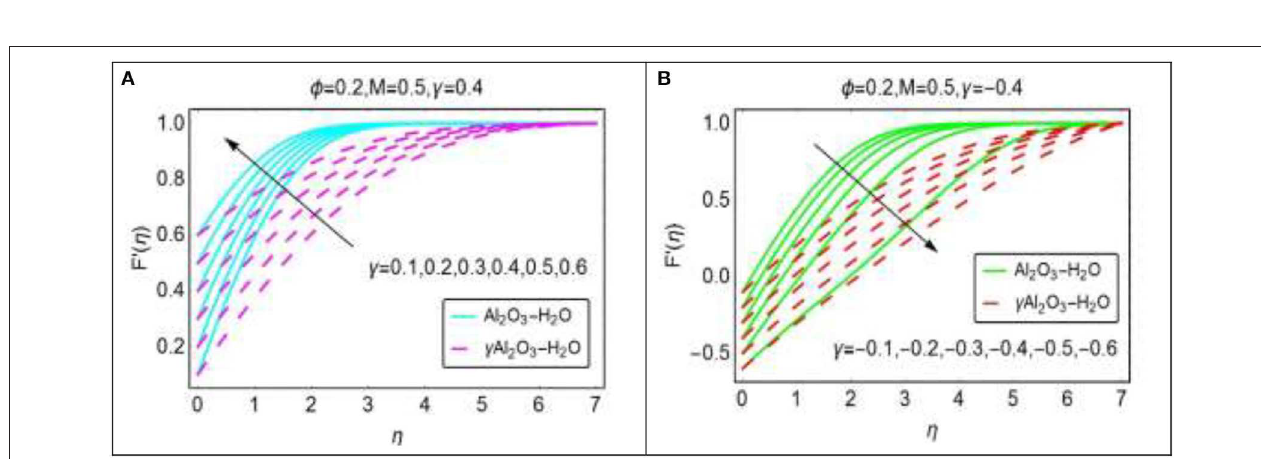
FIGURE 2 | The effects of λ on dimensionless velocity F ′ ( η ) for (A) γ = 0.4, (B) γ = − 0.4.